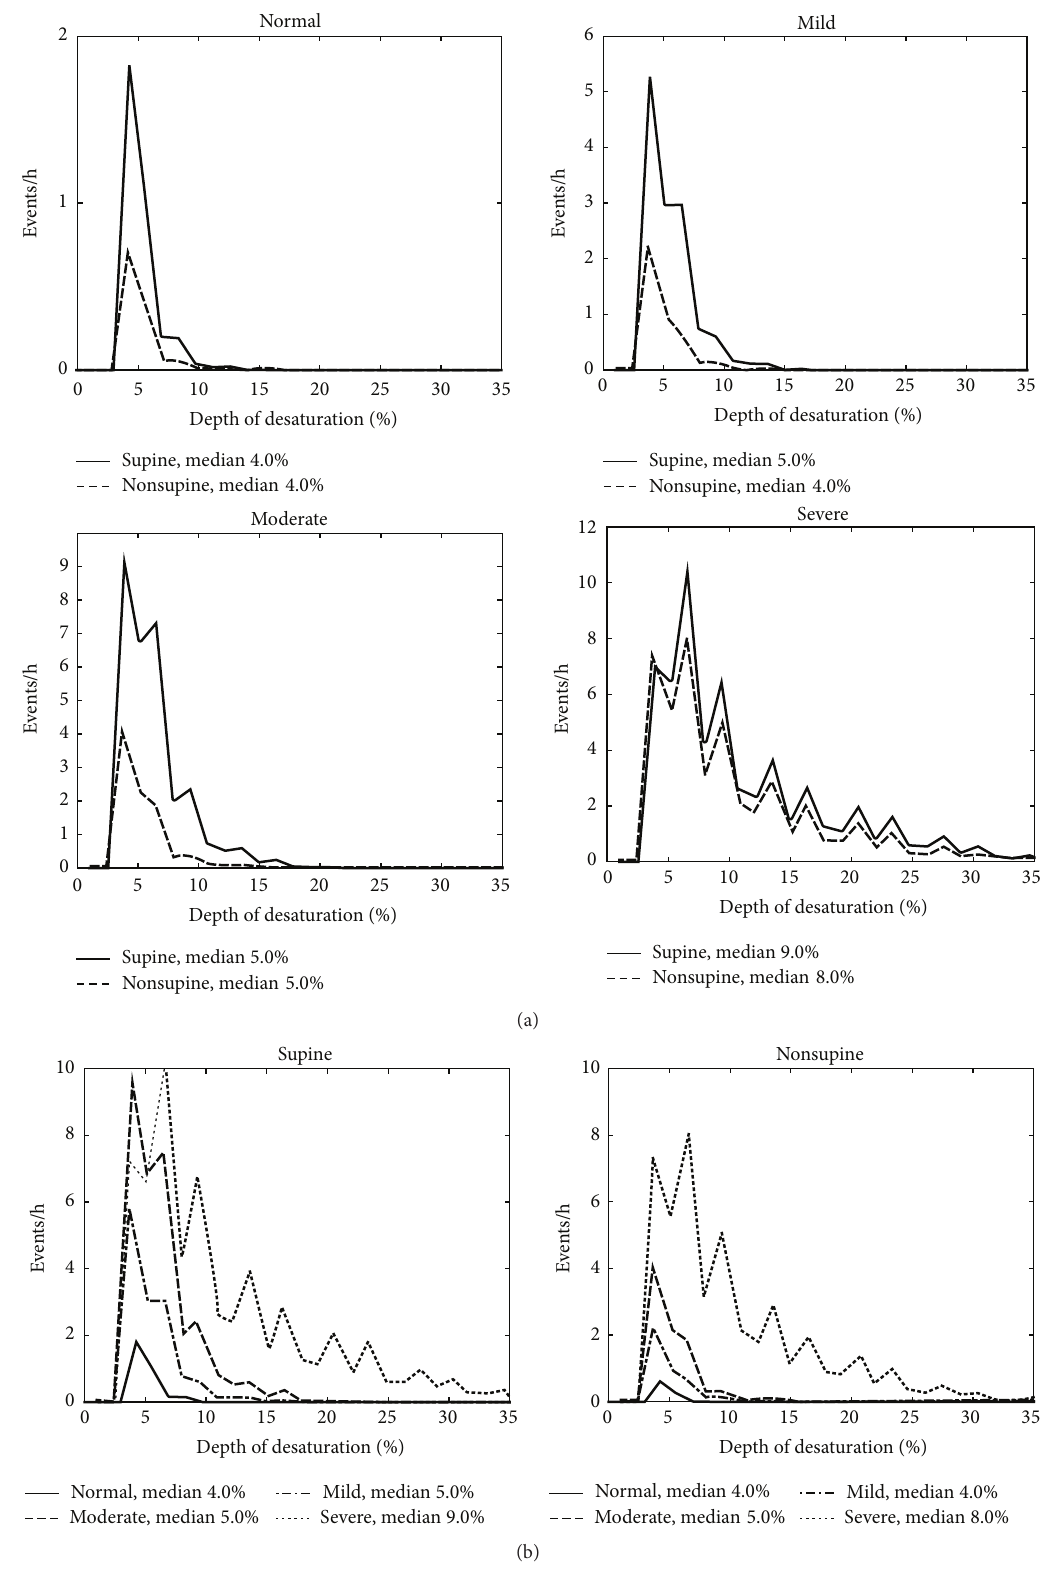
Figure 3: (a) Positional sleeping time adjusted distributions of the depths of individual desaturation events in supine and nonsupine positions in different OSA severity categories and (b) distributions in nonsupine and supine positions as a function of OSA severity. In mild and severe OSA categories the median depths of the desaturation events are greater in the supine position than in the nonsupine position. Based on mixed model analysis, the differences are statistically significant in all OSA severity categories excluding normal